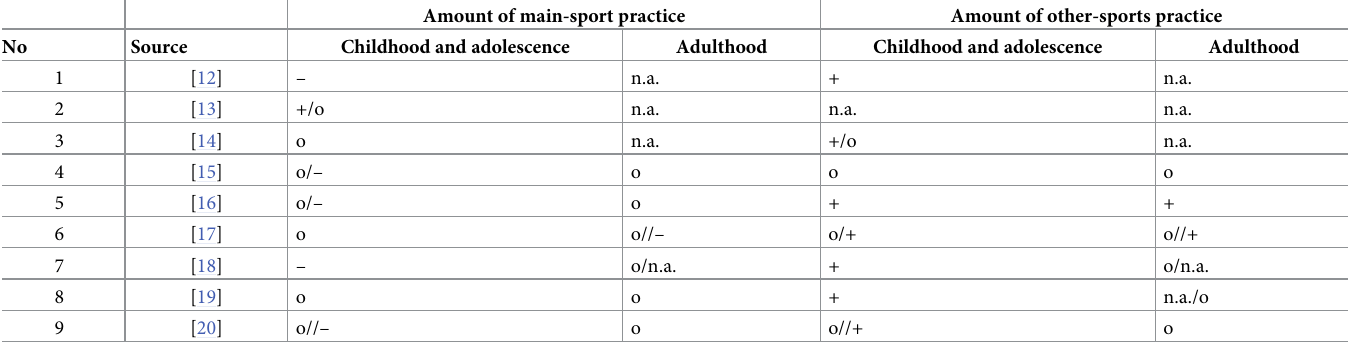
Table 1. Relevance of the volume of coach-led practice in an athlete’s main sport and in other sports for the differentiation between senior international and national-level success (adapted and updated from [11]). Amount of main-sport